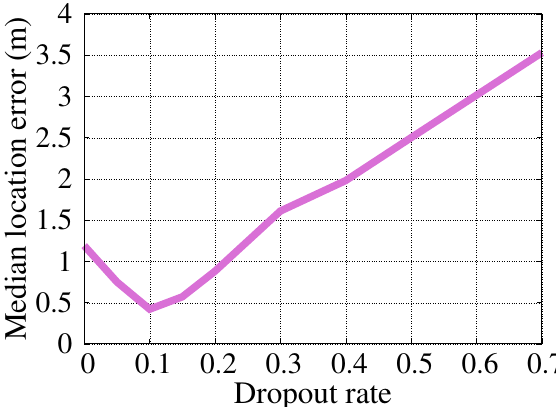
Figure 8. Effect of changing the dropout rate on RRLoc localization error.